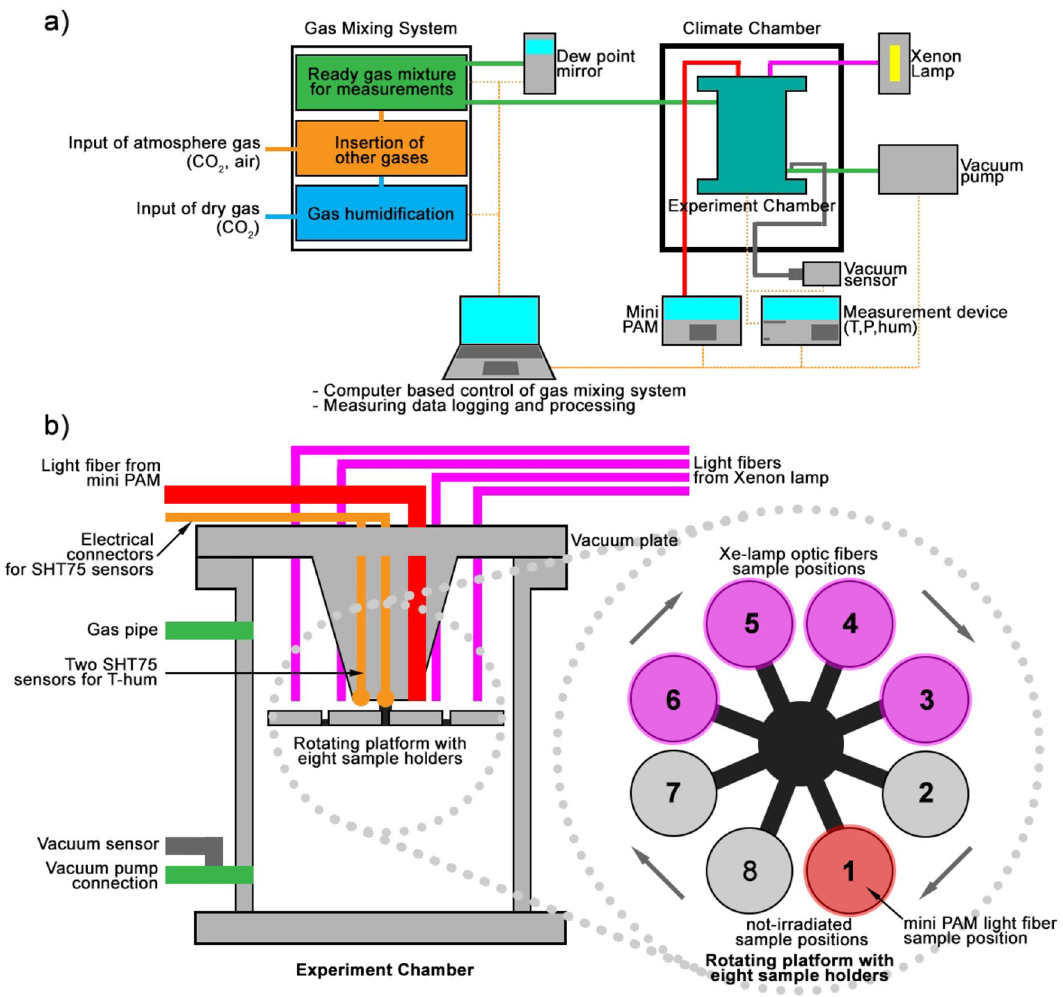
Figure 2. ( a ) Experiment configuration of the PASLAB facility. ( b ) On the left, experiment arrangement inside the experiment chamber, showing UV Xe-lamp optical fibers and Mini PAM light fiber connections. Gas connections are shown too. On the right, above vision on the turntable/rotating platform with the eight sample holders. Range of experimental and environmental